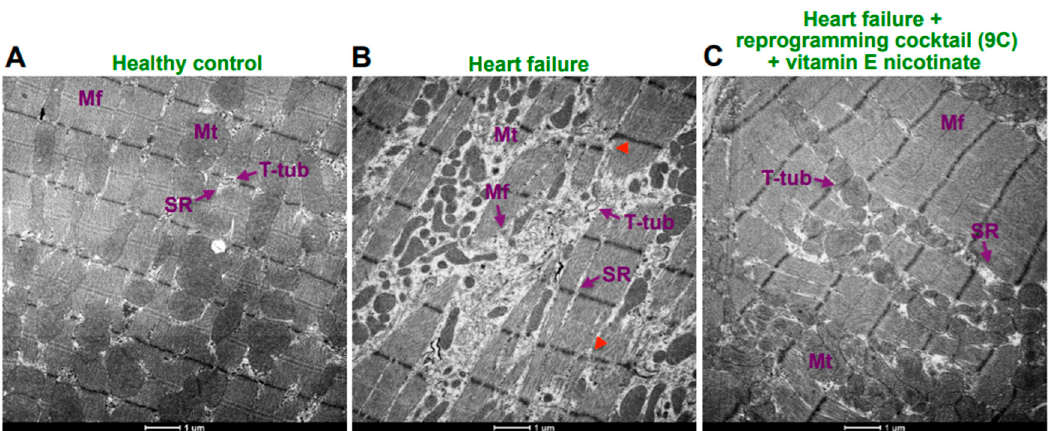
Figure 3. Effects of pharmacologic reprogramming drug cocktail (9C) and vitamin E nicotinate on cardiac fibrosis. Sprague-Dawley rats were subcultaneously injected with SU5416 (20 mg/kg body weight) and subjected to chronic hypoxia at 10% O 2 for 3 weeks and then maintained in normoxia to promote pulmonary hypertension-induced right ventricular fibrosis [32]. Eight weeks after the injection of SU5416, a combination of cell reprogramming drugs (9C) as described by Cao et al. [13] was injected intraperitoneally with or without vitamin E nicotinate twice over the one-week period. Right ventricular tissues were fixed in buffered formalin, embedded in paraffin, and subjected to Masson’s trichrome staining. Blue color indicates fibrosis. ( A ) Healthy control; ( B ) Heart failure; ( C ) Heart failure + reprogramming cocktail (9C); ( D ) Heart failure + reprogramming cocktail (9C) + vitamin E nicotinate. Magnification 400×.